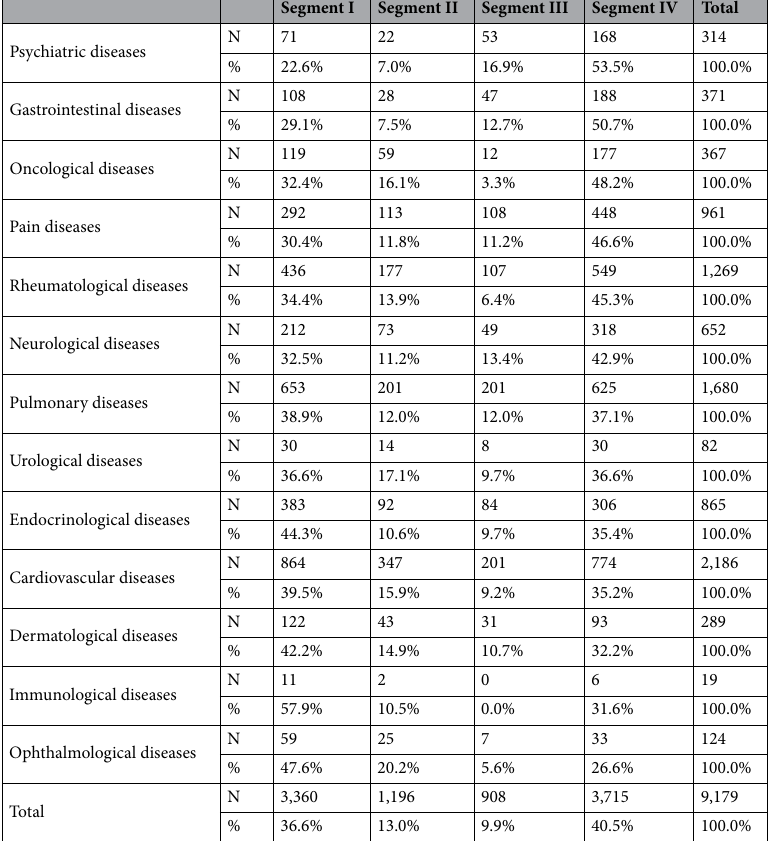
Table 4. Patient reported burden of disease ranking excluding